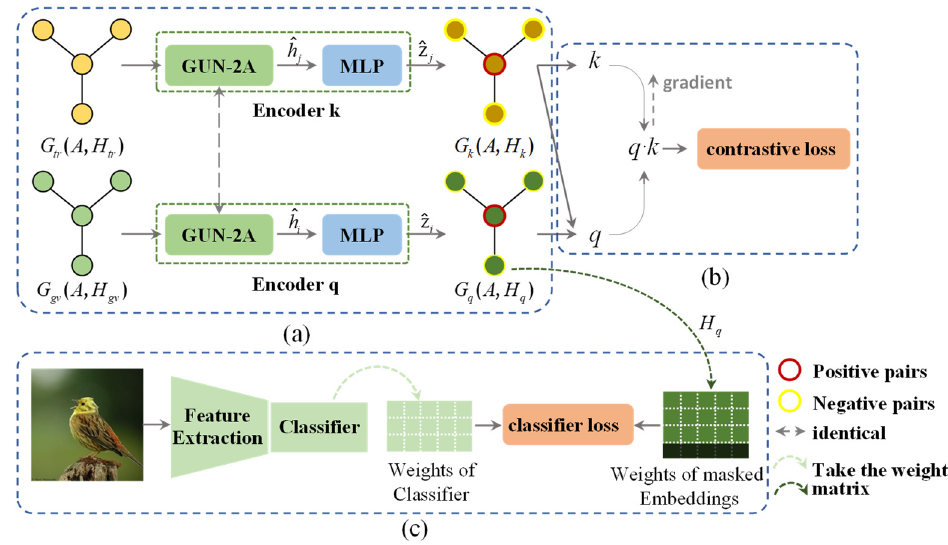
Figure 3. The overall framework of the proposed zero-shot classification model CGUN-2A. The model is constructed by ( a ) graph encoder, ( b ) contrastive learning module and ( c ) classifier learning module.